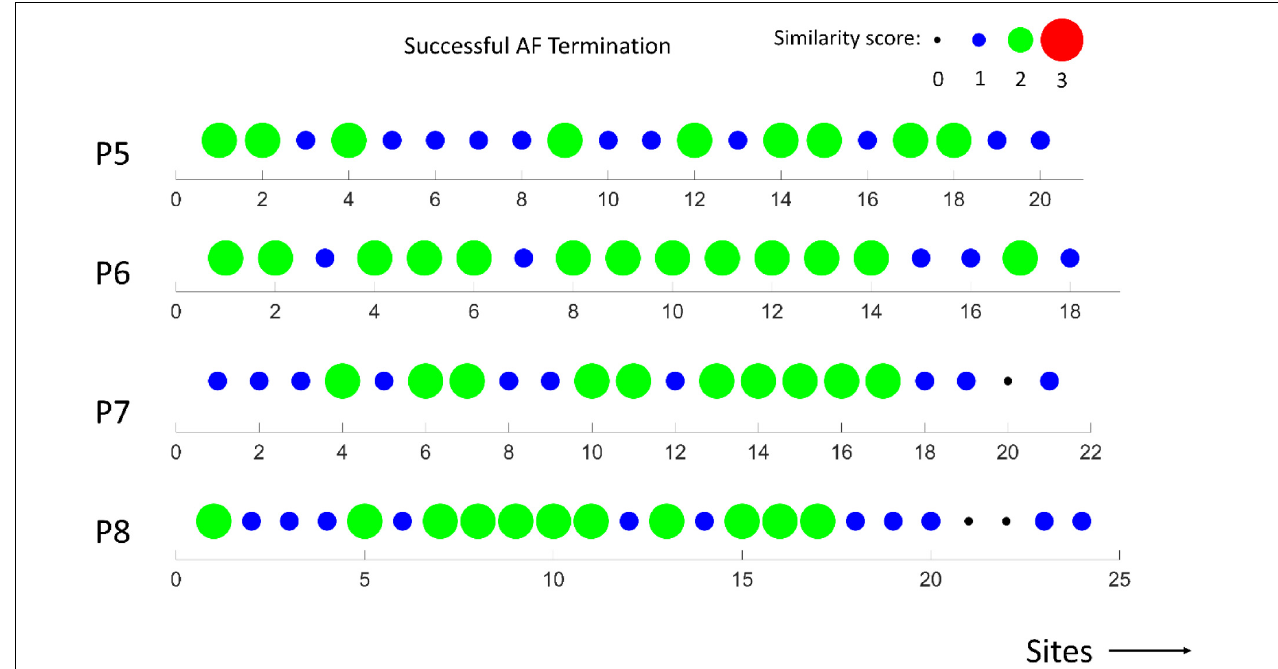
FIGURE 7 | Similarity scores calculated at different spatial sites in m = 4 patients with successful AF termination. Notably, the absence of active AF sites with a high similarity score